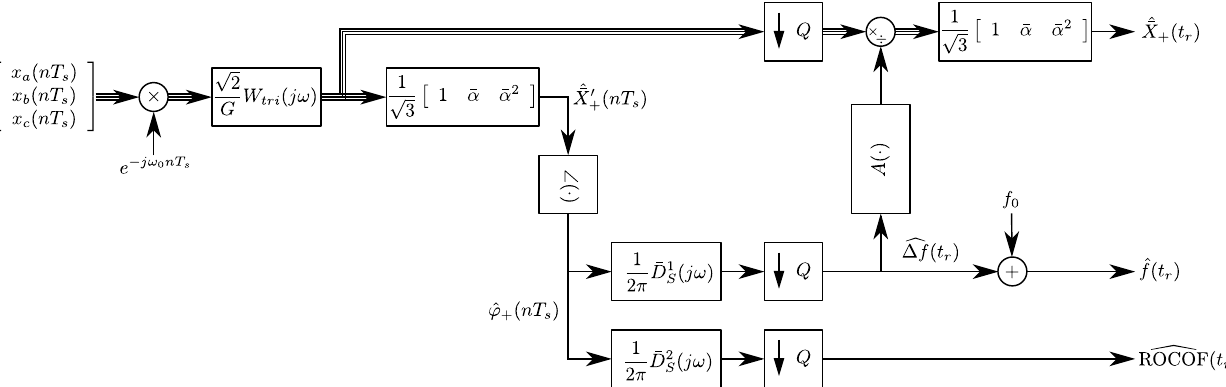
Figure 1. Block diagram of the IEC-P